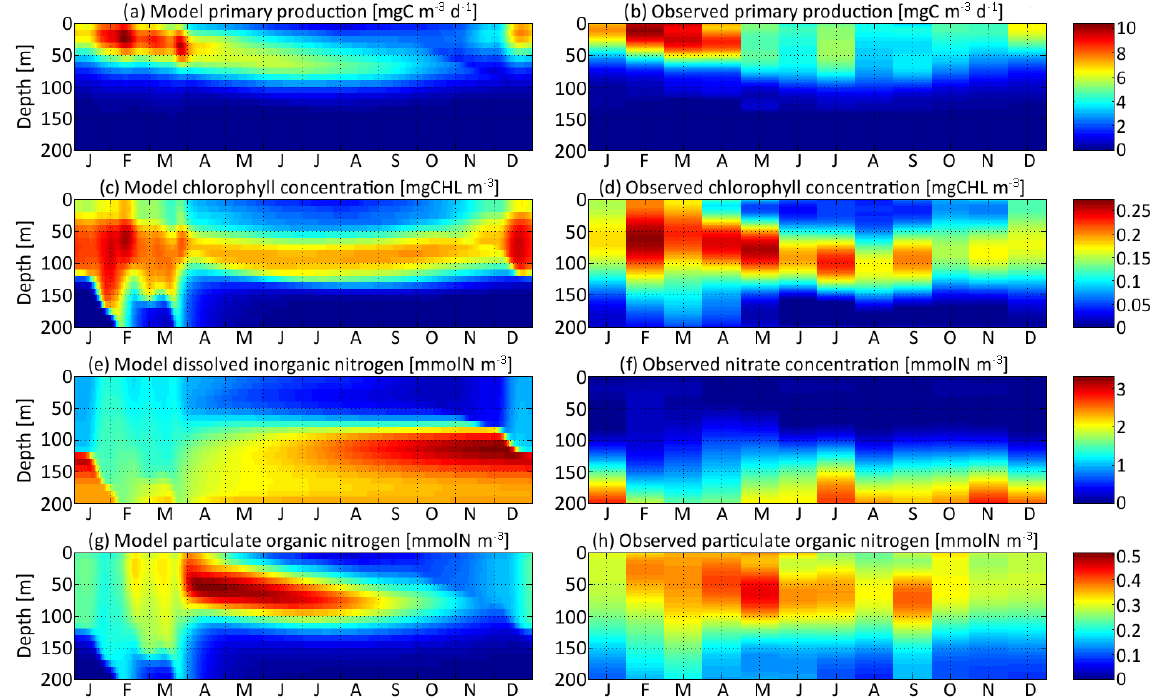
Figure 4. Distribution in depth and time of (a) model primary production, (c) chlorophyll concentration, (e) dissolved inorganic nitrogen con- centration, and (g) particulate organic nitrogen concentration for ν x = 0 . 001 and ν y = 0 . 01 ◦ C 2 . Each variable is compared with equivalent observations in the Sargasso Sea (b, d, f, h)